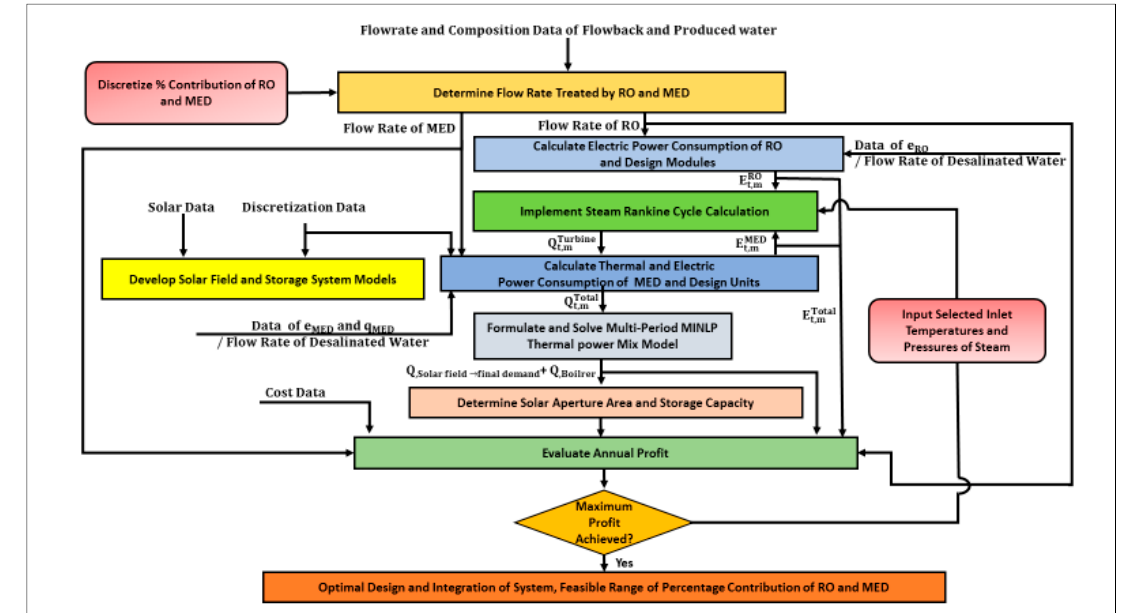
Figure 2. Proposed approach.